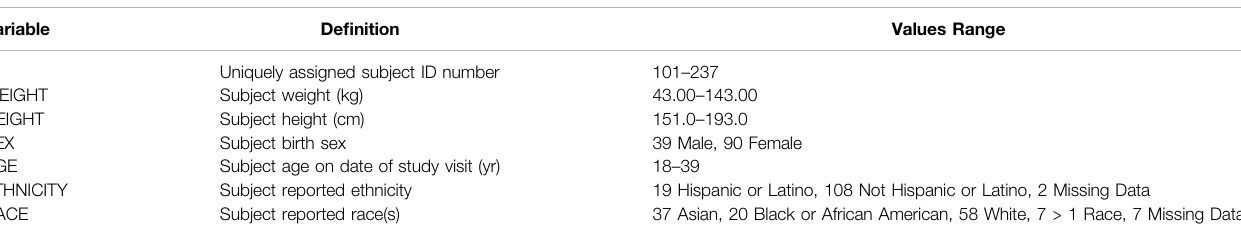
TABLE 2 | Demographics dataset variables